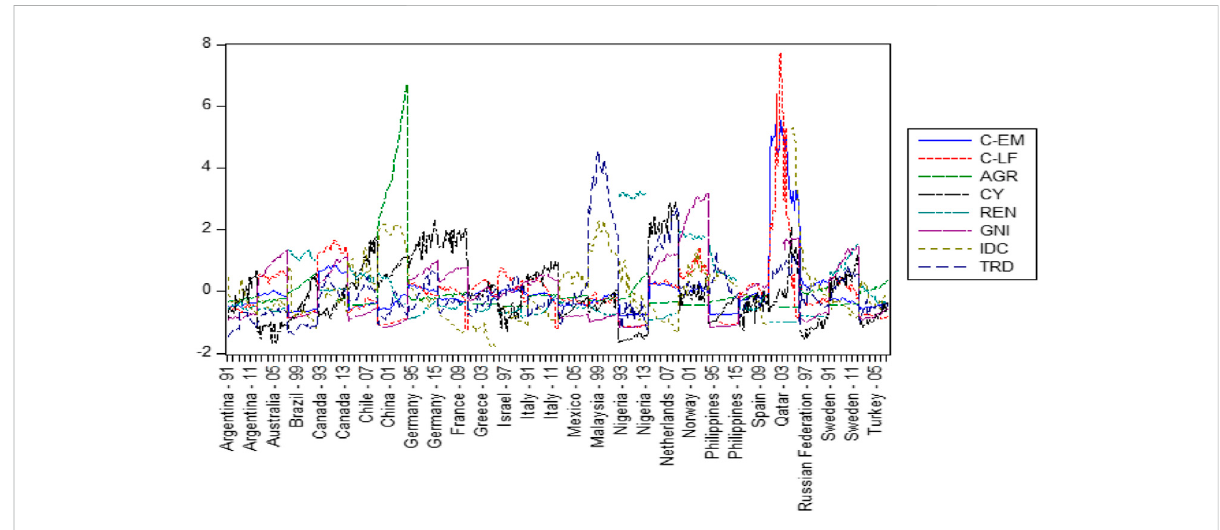
FIGURE 4 Consequences of CEM and economic growth in panels A and